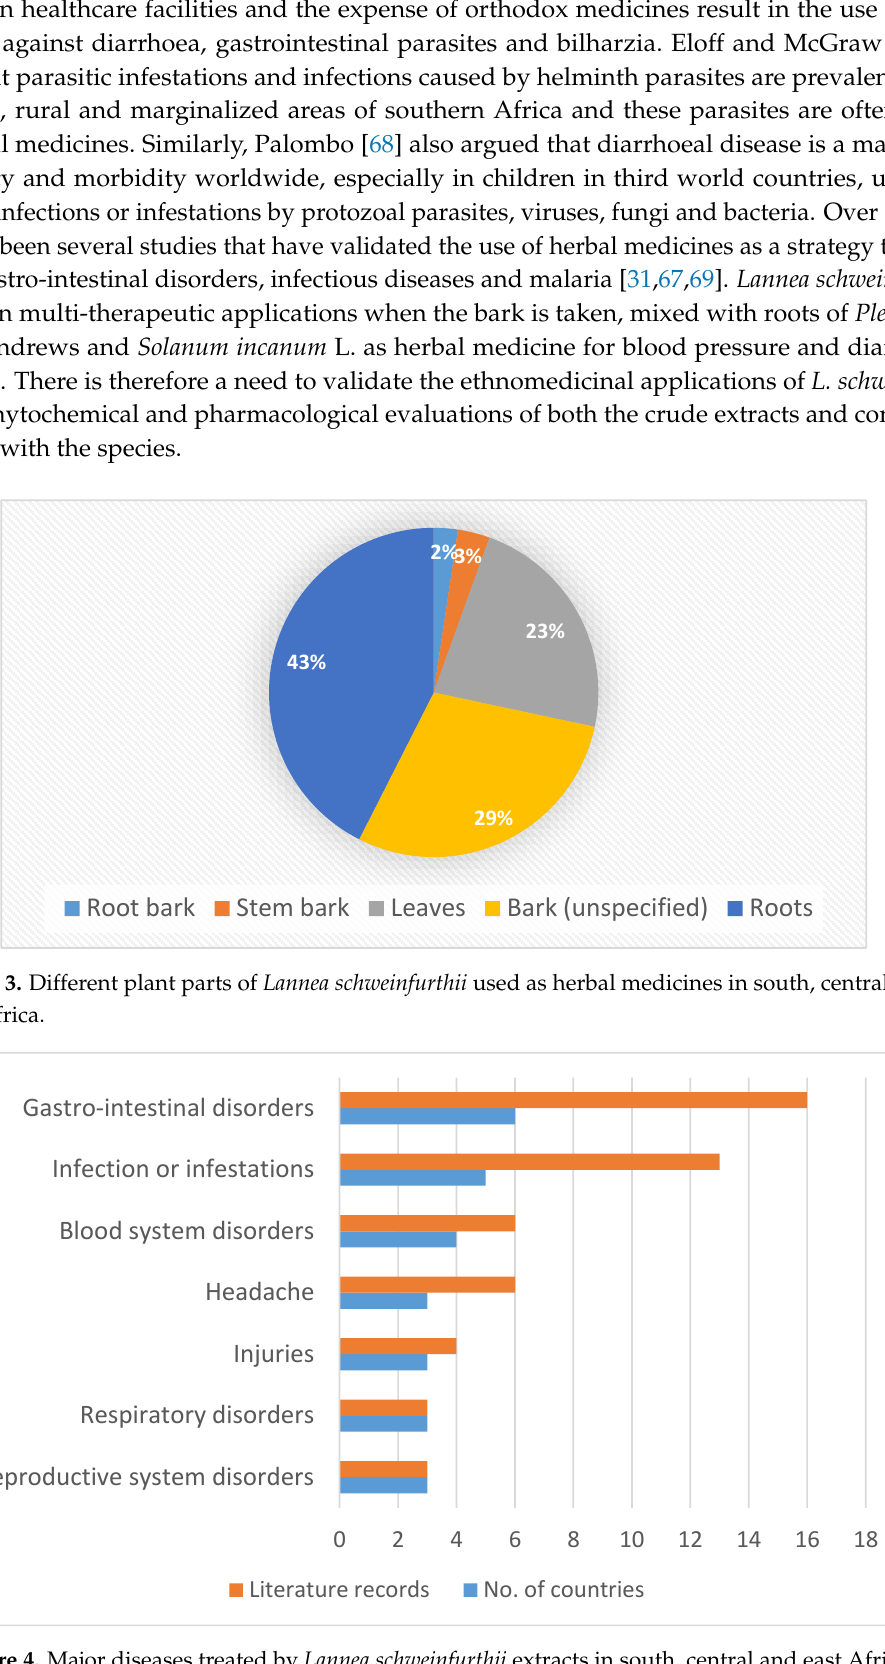
Figure 4. Major diseases treated by Lannea schweinfurthii extracts in south, central and east Africa. 5. Phytochemistry of Lannea schweinfurthii